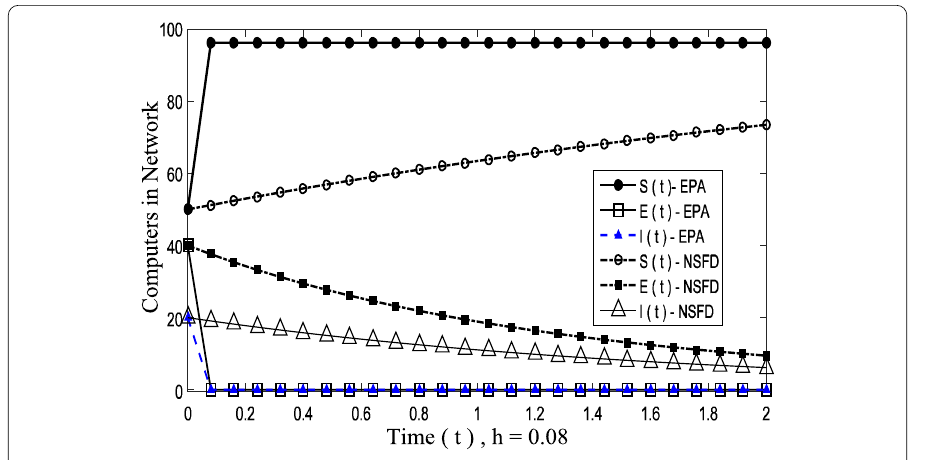
Figure 7 Convergence curves of EPA and NSFD to VFE with h = 0.08